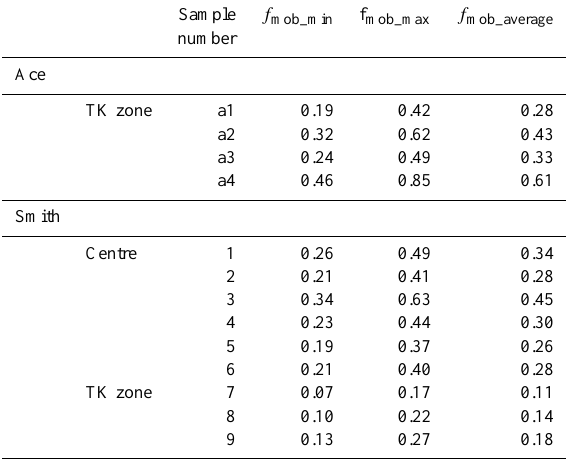
Table 3. Estimated contribution of MOB to the diploptene signal. Calculations assume fractionation due to biosynthesis of 10‰ for MOB and 4‰ for heterotrophic bacteria. f mob_min was calculated assuming the highest fractionation for both MOB and heterotrophs (30 and 4‰ respectively). f mob_max assumes no fractionation dur- ing assimilation. f mob_average was calculated using average δ 13 C values for δ 13 C mob-hopane and δ 13 C hetero-hopane .